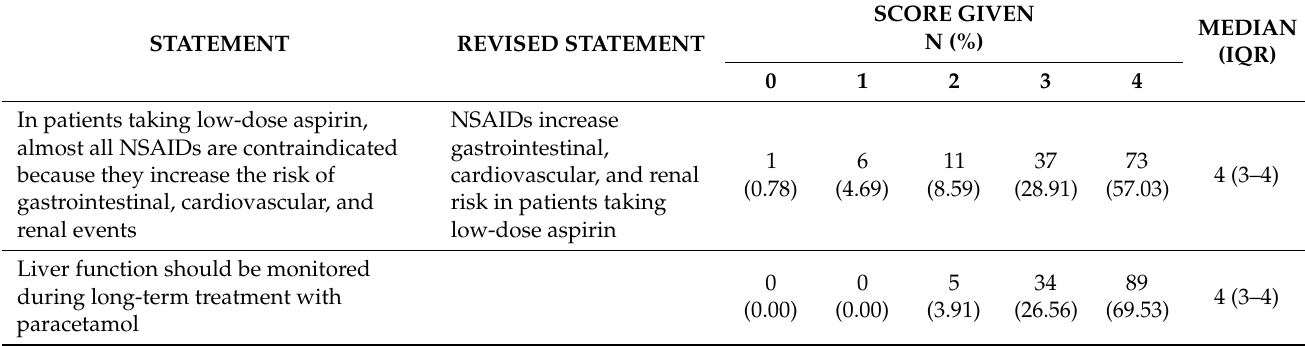
Table 1. Statements for which consensus was